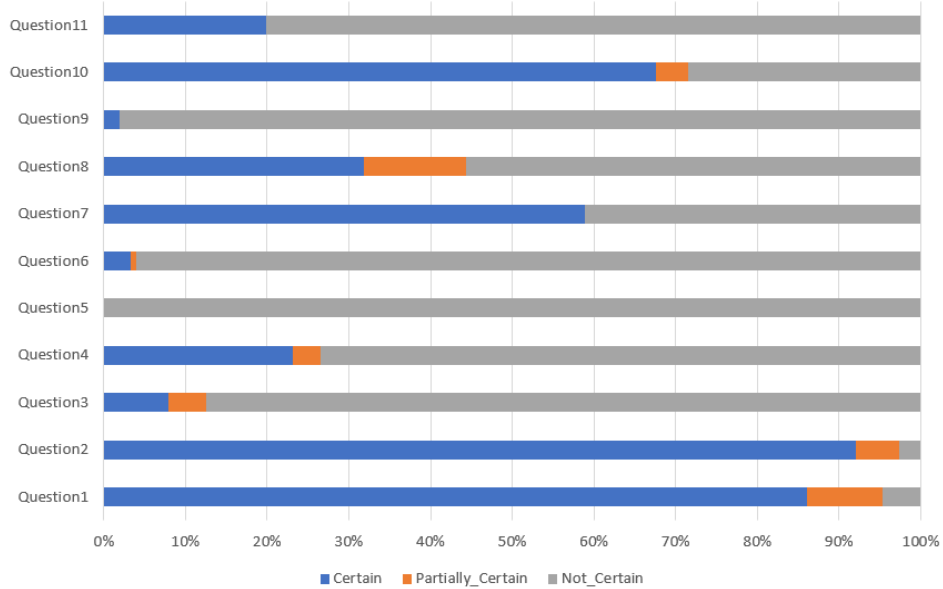
Figure 3. Summary of the items answered by reviews.